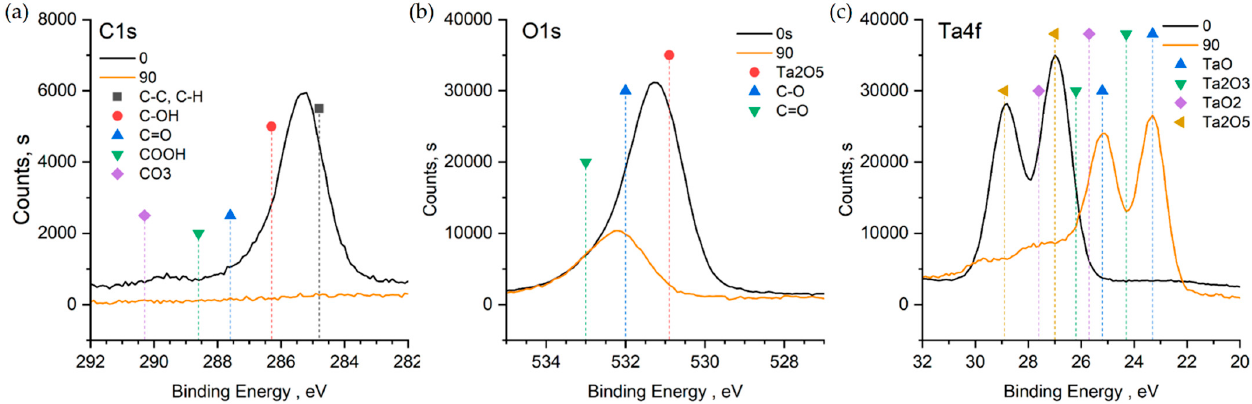
Figure 4. XPS spectrum for Ta-O_11 C1s ( a ), O1s ( b ), Ta4f ( c ). According to the XPS spectra of the Ta4f level, Ta 2 O 5 is located on the sample surface.